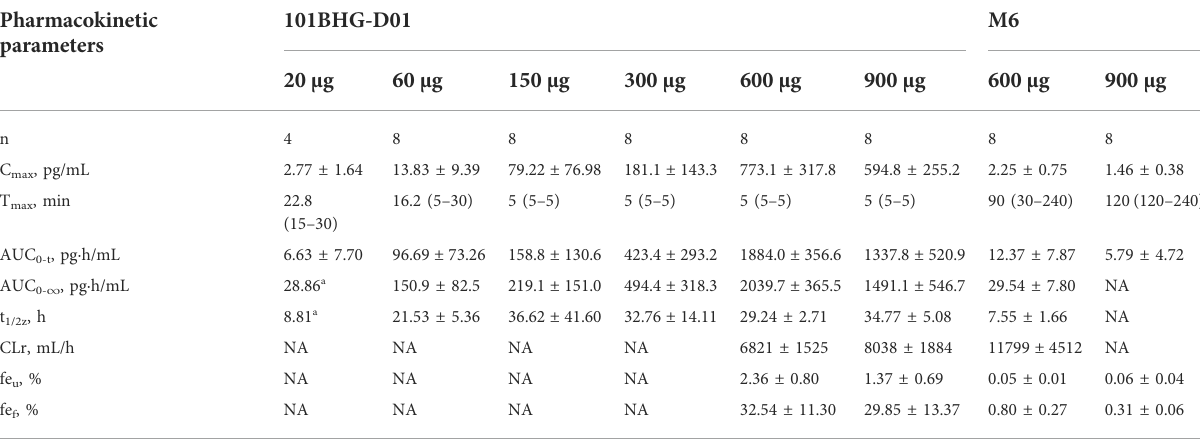
TABLE 2 Main pharmacokinetic parameters of 101BHG-D01 and M6 after single inhaled doses of 101BHG-D01 in healthy Chinese subjects. Pharmacokinetic